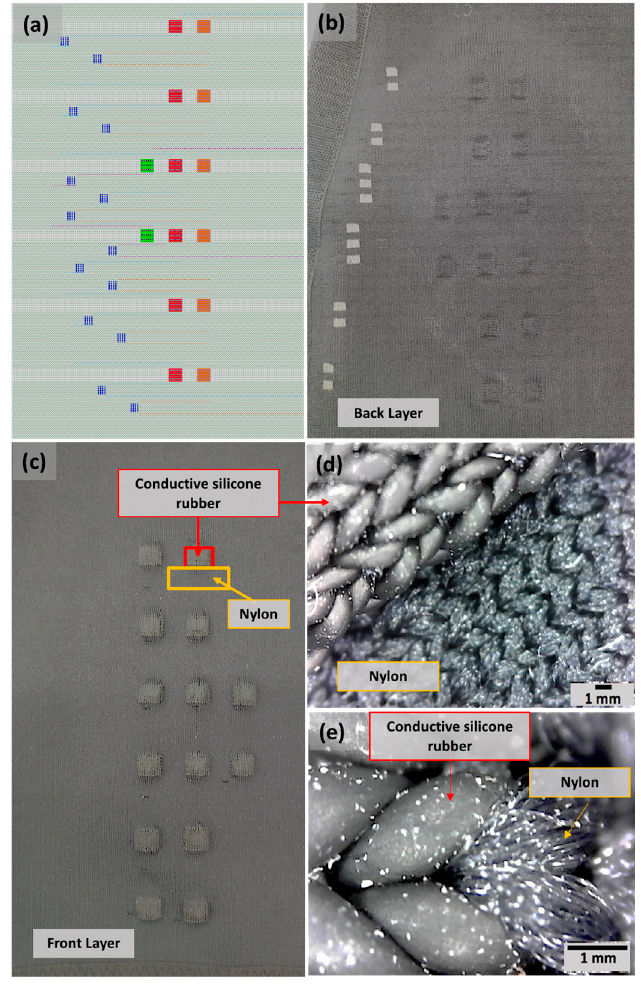
Figure 4. Textile sleeve with an embedded EMG electrode array: ( a ) Textile sleeve simulated fabric view; ( b ) Textile EMG sleeve outer view; ( c ) Textile EMG sleeve inner view; Optical microscope images showing seamless embedding of the electrode structure within a passive sleeve garment.